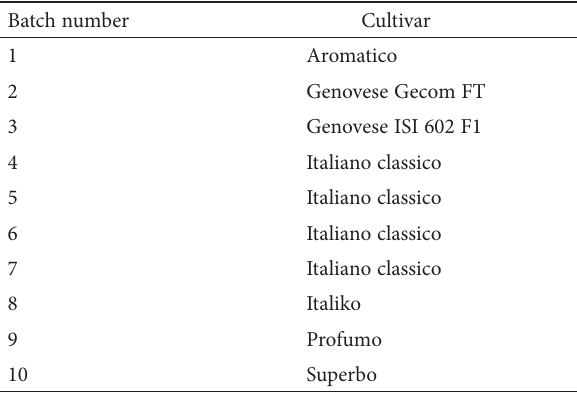
Table 3. List of commercial basil seed cultivars of the ‘Genovese’ type reported as susceptible to black spot, and used in the present study to detect and quantify the presence of Colletotrichum ocimi